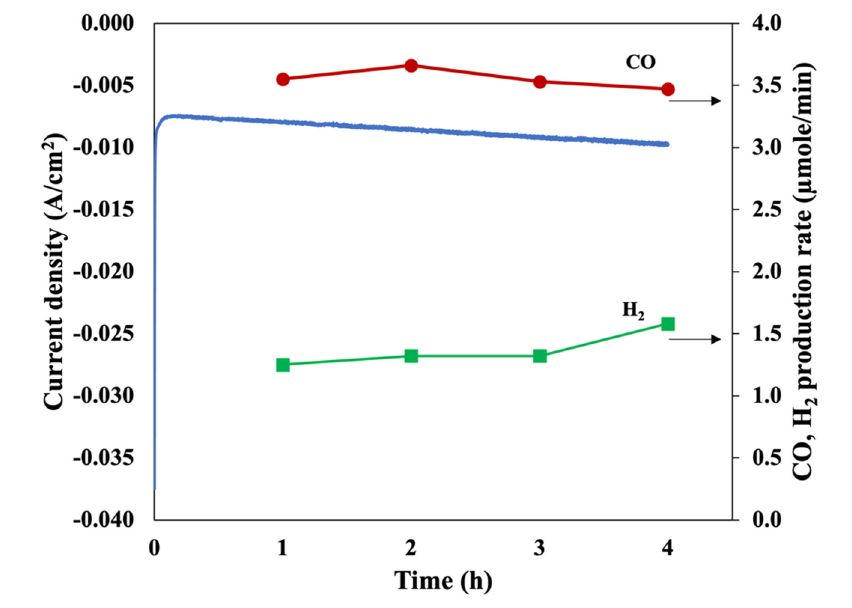
Figure 7. Catalytic performance of Zn/Cu–Na200 at − 1.6 V vs. Ag/AgCl for 4 h.